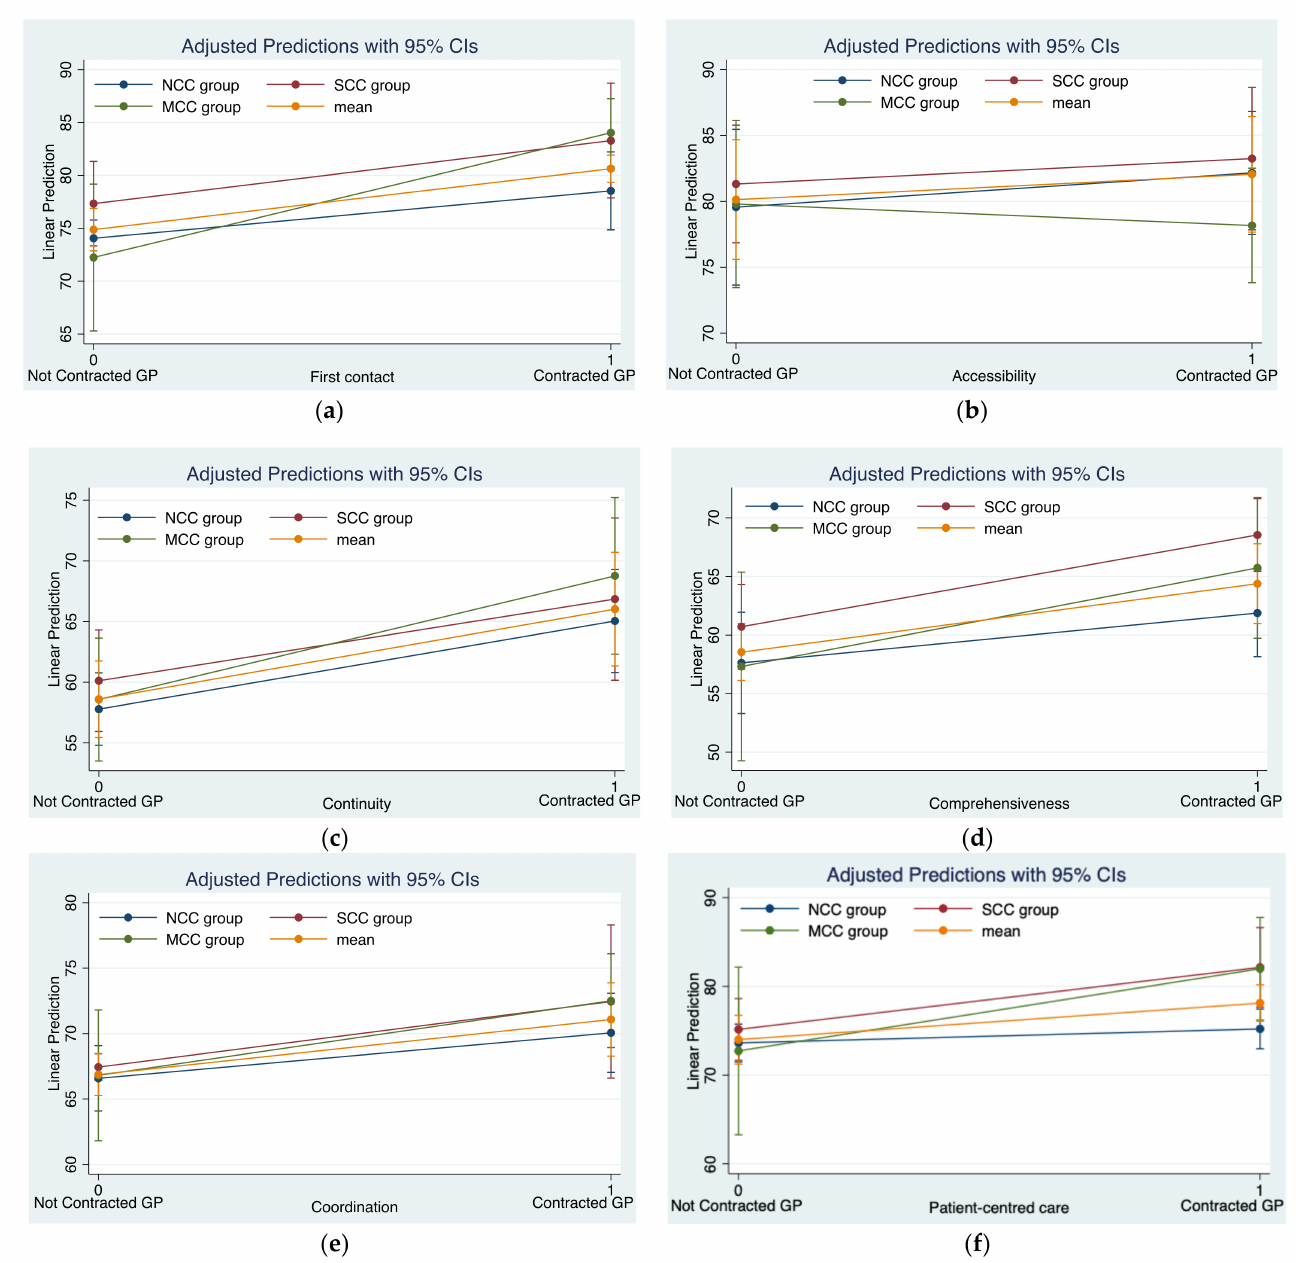
Figure 2. Interaction plots of the adjusted estimates for primary care attribute scores for contract services and chronic conditions. NCC, non-chronic condition; SCC, single chronic condition; MCC, multiple chronic conditions. ( a ) In first contact dimension, the change in predicted scores from not contracted GP to contracted GP for each chronic condition group. ( b ) In accessibility dimension, the change in predicted scores from not contracted GP to contracted GP for each chronic condition group. ( c ) In continuity dimension, the change in predicted scores from not contracted GP to contracted GP for each chronic condition group. ( d ) In comprehensiveness dimension, the change in predicted scores from not contracted GP to contracted GP for each chronic condition group. ( e ) In coordination dimension, the change in predicted scores from not contracted GP to contracted GP for each chronic condition group. ( f ) In patiented-centred dimension, the change in predicted scores from not contracted GP to contracted GP for each chronic condition